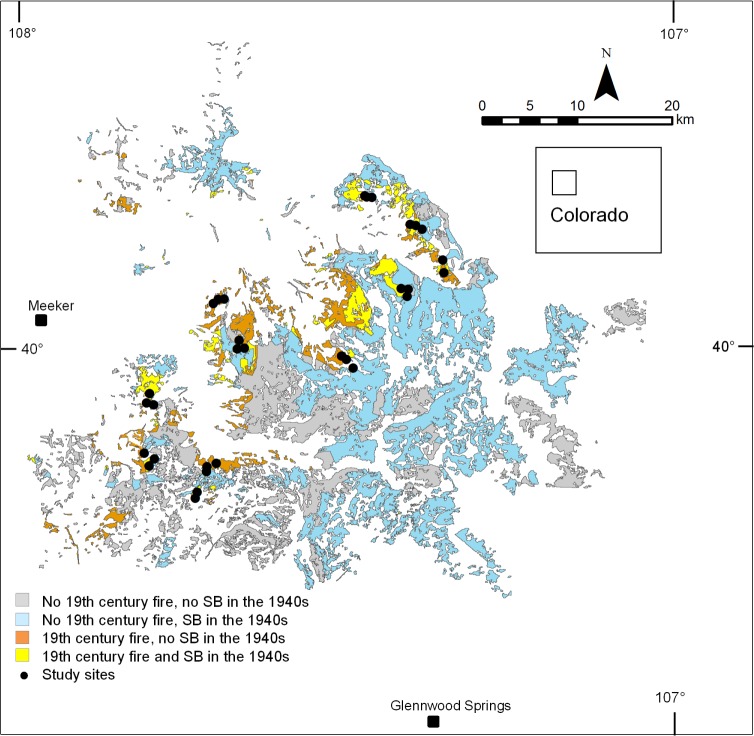
Location of study sites.Areas affected by the 19th century fires and by the 1940s spruce beetle (SB) outbreak as reconstructed by Bebi et al. [32].